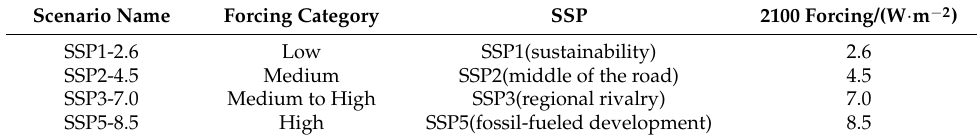
Table 3. The Shared Socioeconomic Pathways (SSP) of CMIP6 used in this